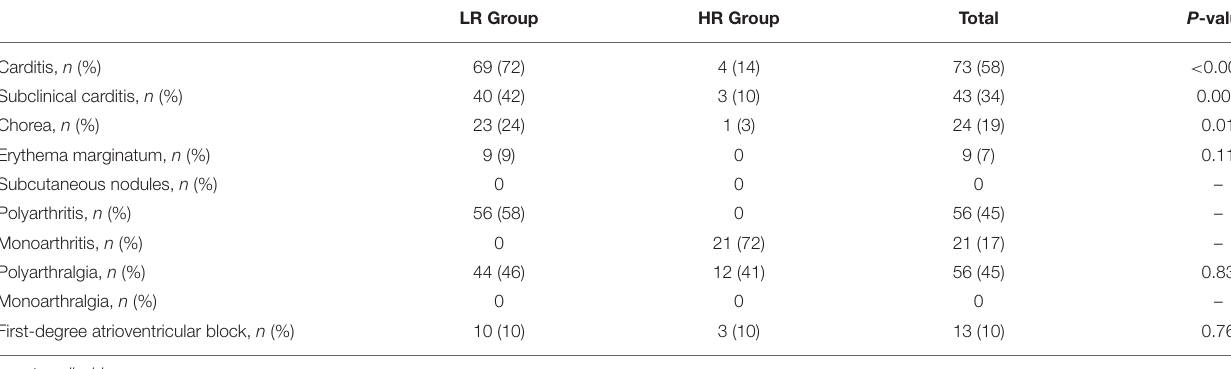
TABLE 3 | Main clinical manifestations of patients.